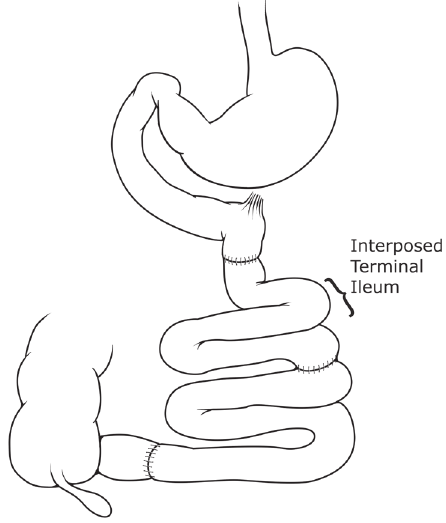
Figure 5. Ileal interposition. A neurovascular intact segment of distal or near-terminal ileum is interposed in the proximal jejunum near the ligament of Treitz. The distal jejunum is then re-anastomosed to the small segment of ileum proximal to the ileocecal valve to re-establish bowel